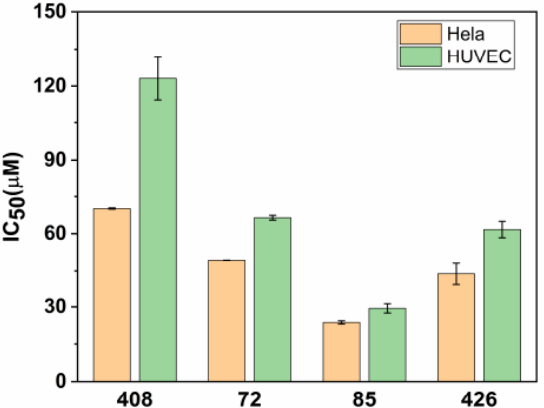
Figure 3. Half inhibitory concentration (IC 50 ) values of compounds 72 , 85 , 408 , and 426 for Hela and HUVEC (human umbilical vein endothelial cells) cell lines (mean ± SEM, standard error of mean was calculated with three replicates).